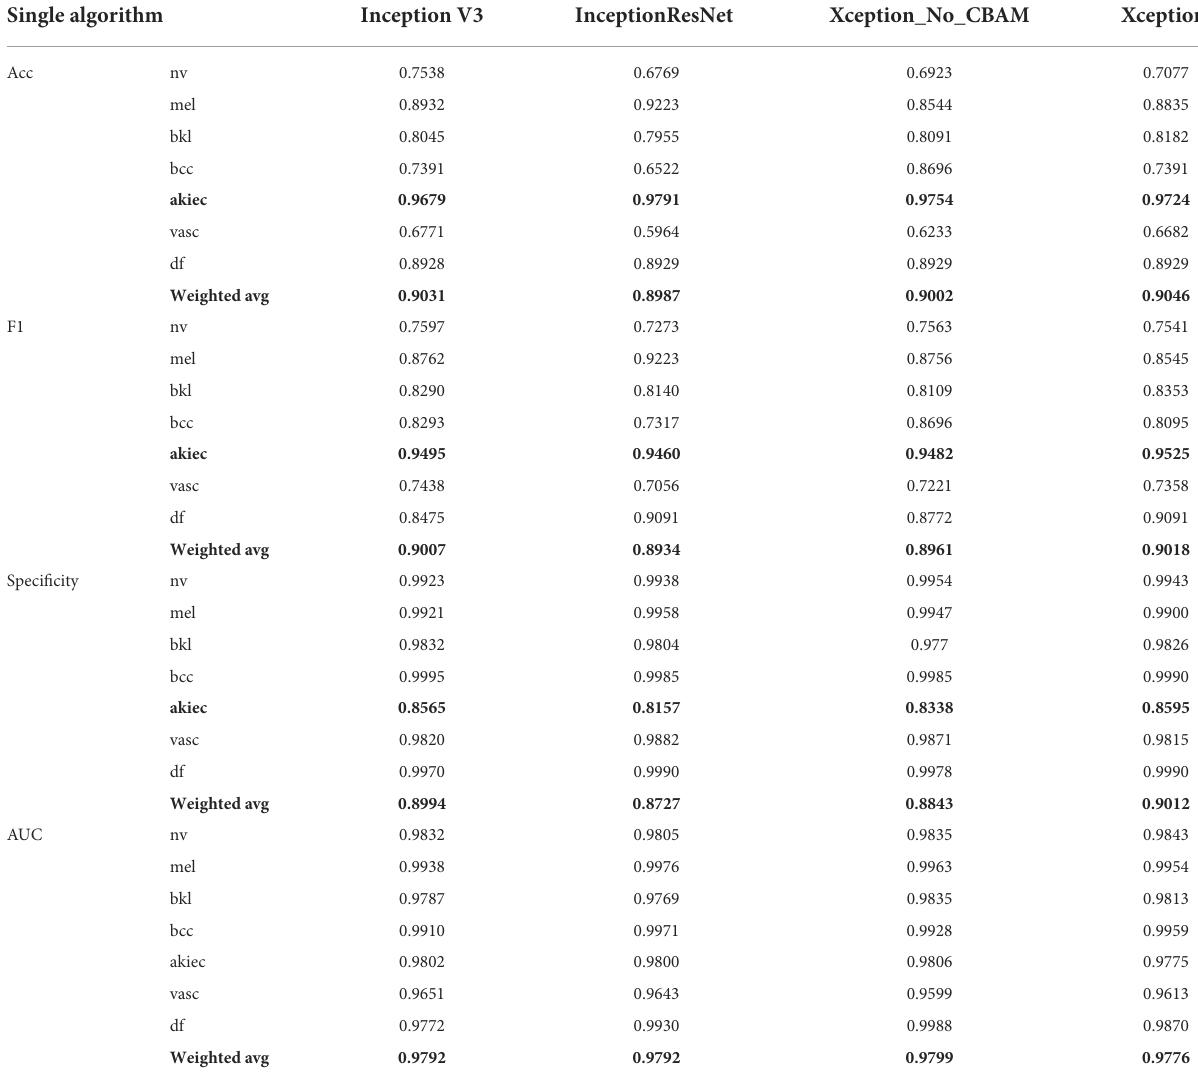
TABLE 4 The influence of a single network model on evaluation